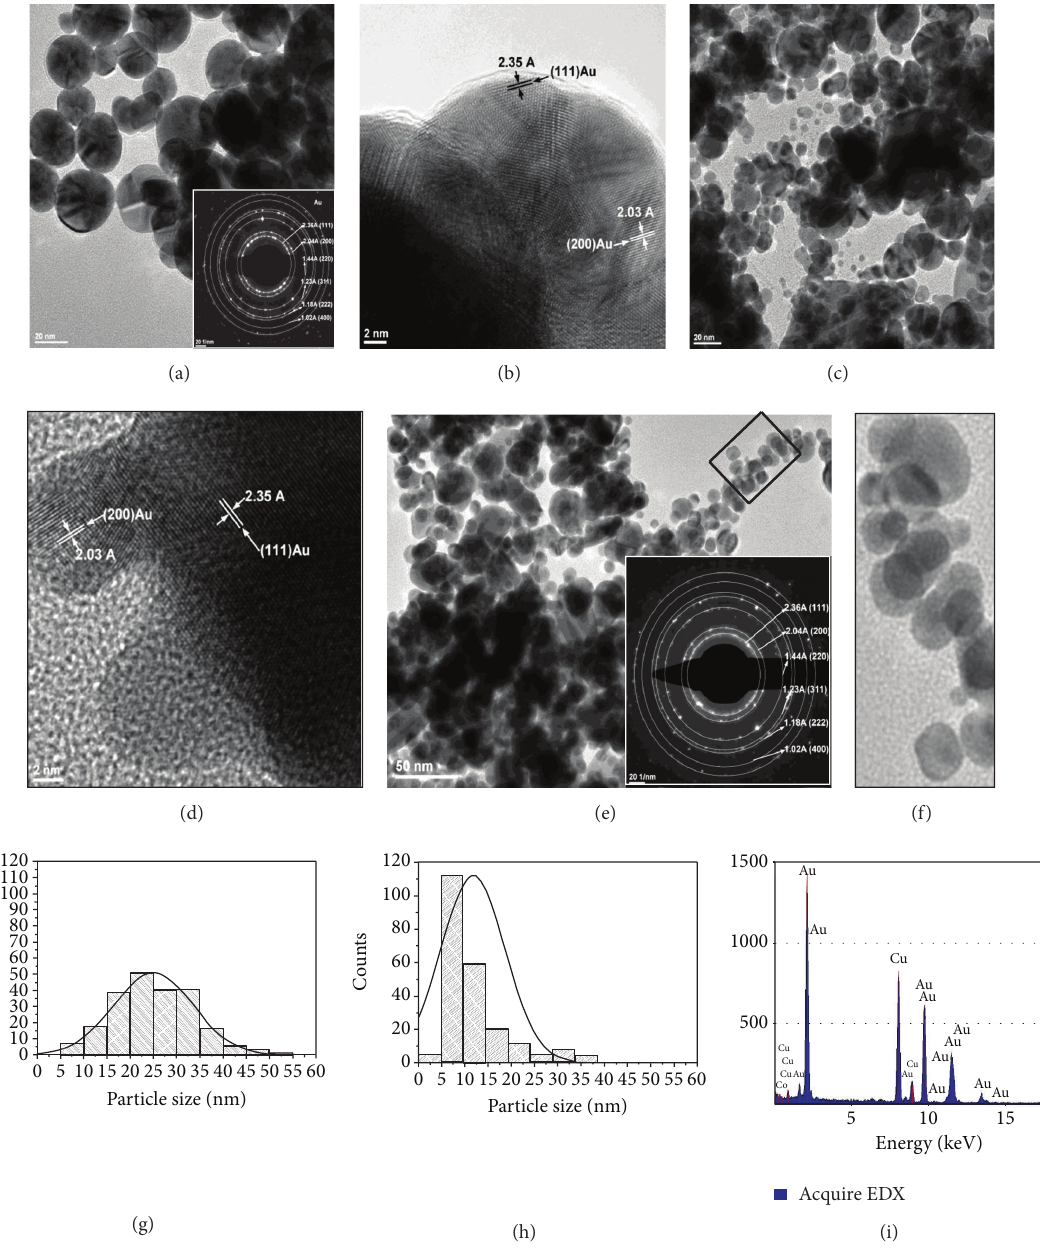
Figure 2: TEM and HR-TEM images presenting the influence of dendrimer concentration over the dimension of Au-G2-5 ((a) and (b); scalebar 20 nm) and Au-G2-2.5 ((c)–(e); scalebar 2nm). (a), (c), (e) General views with insets presenting representative SAED patterns for gold (fcc); (b) two Au-G2-5 highly crystalline nanoparticles coated by a thin organic exterior shell; (d) two small but still crystalline Au-G2- 2.5 nanoparticles onto the surface of a larger particle; (e) different populations of particles coexist; the small particles are more numerous; spherical entities around 3.8 nm are visible; (f) selected area from (e). Corresponding histograms of the particles size distribution are also included ((g), (h)). (i) EDX spectrum as recorded for